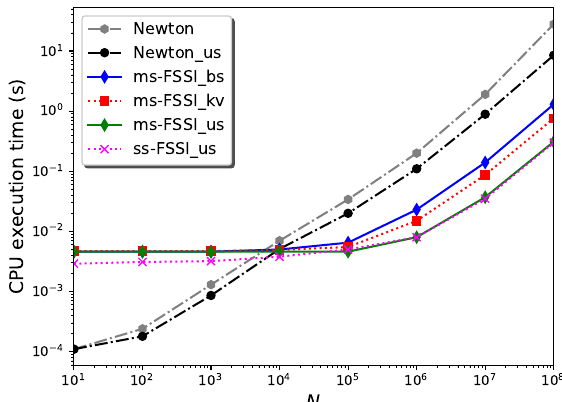
Figure 2. CPU execution time ( s ) for different routines as a function of the number N of y values in which the inverse of f ( x ) = x e sin x has to be computed. These results correspond to e = 0.9 and an − error level 10 − 15 rad. All results have been obtained with the computer hardware specified in the text. The prefix ms- indicates the routines using the multistep method described in Section 3, as opposed x min ) / n ss , with n ss = 13,500 to those indicated with the prefix ss- that use a single step h = ( x max − (for e = 0.9) to attain the same error